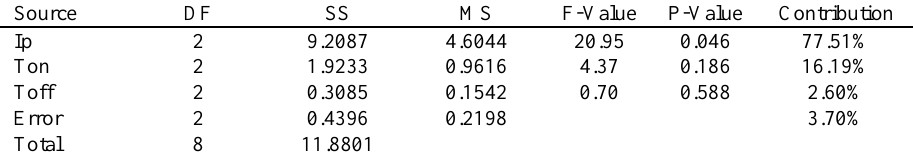
Table 8. ANOVA for S/N ratio of Gr electrode surface